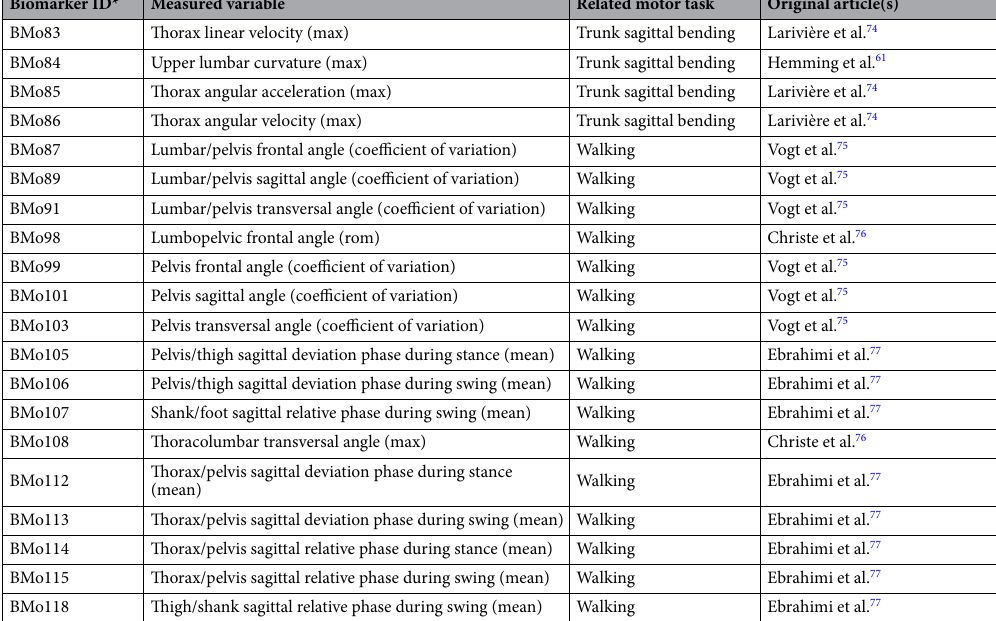
Table 1. Characteristics of the movement biomarkers assessed in this study. *Biomarker identifiers (ID) used in the systematic review of Moissenet et al. 6 . Biomarkers having reached at least good levels in the reliability domain are highlighted in italic, in reliability and validity in bold italic, and in reliability, validity and interpretability in bold (see Table 2 for measurement properties